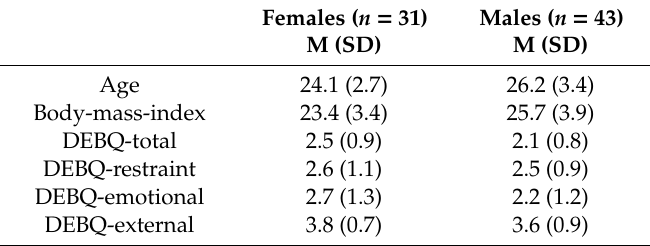
Table 1. Summary of participants’